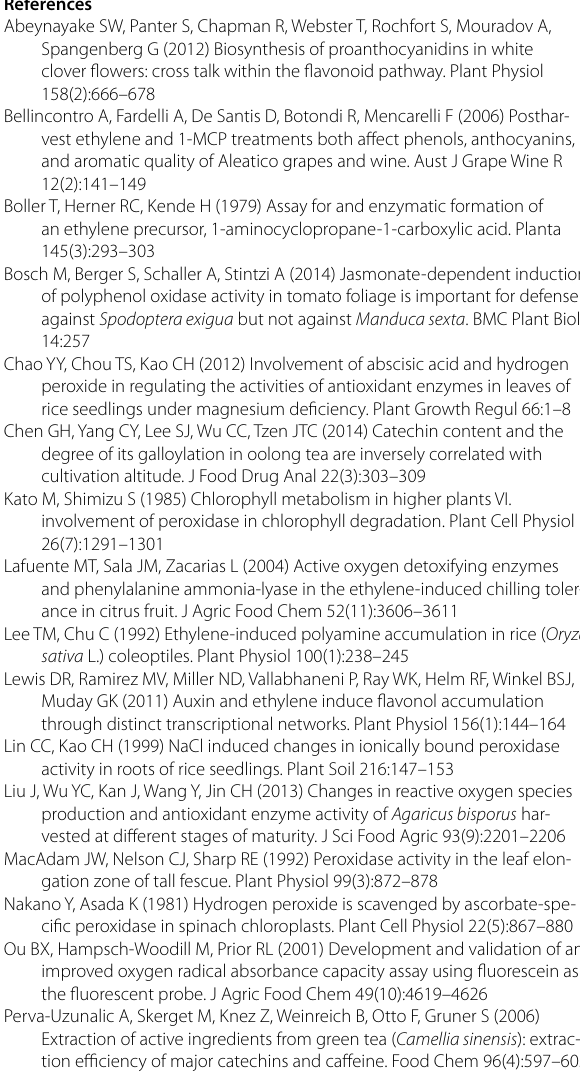
Fig. 5 ORAC in tea seedlings on modulation of ethylene signaling. ORAC‑FL values were determined from the detached tea seedling samples after treatment with the control (CK) or 100 μM ACC for 5 days. Data points are mean SD of three biologically independ‑ ± ent experiments. Asterisks indicate significant differences from the control sample (P < 0.05; Student’s t